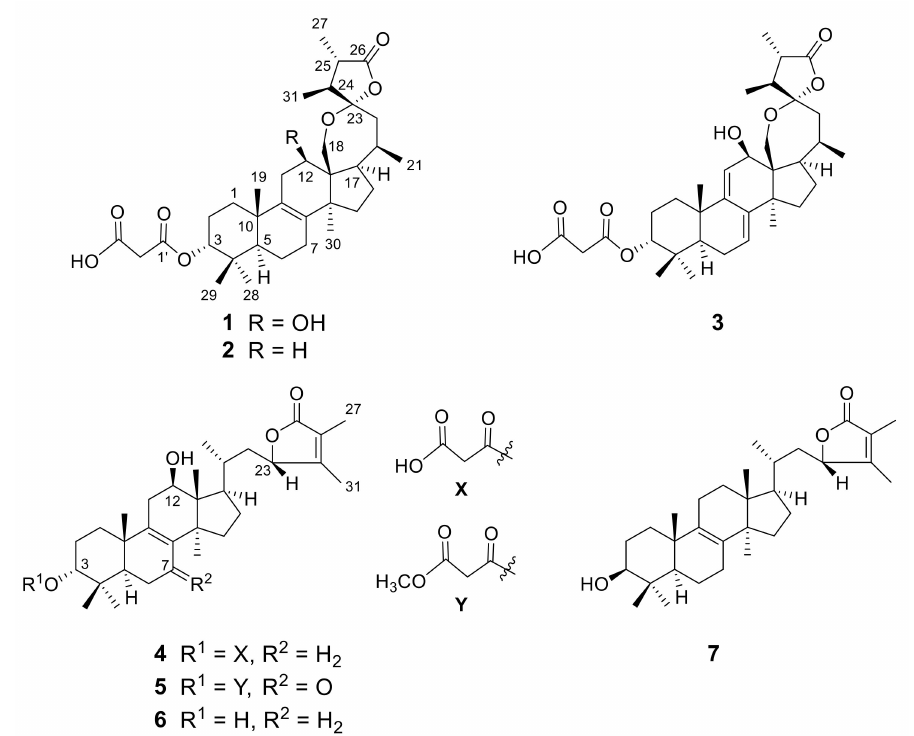
Figure 1. Structures of compounds 1 − 8